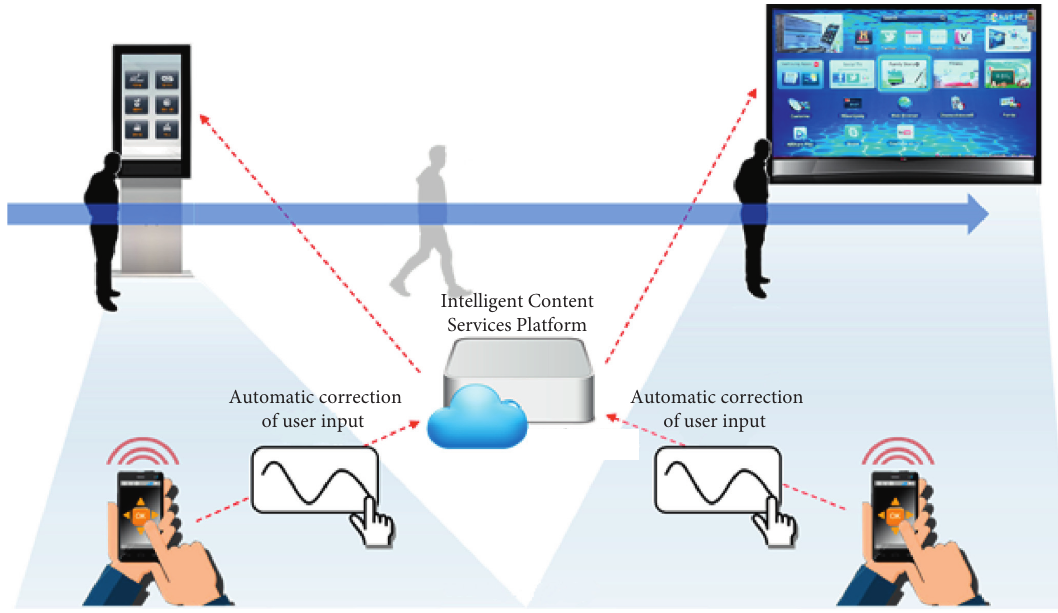
Figure 2: Message and content